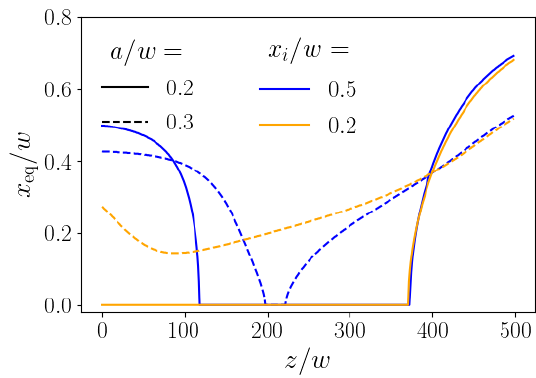
Figure 12. Instantaneous stable fixed points resulting from the applied forces in Figure 11